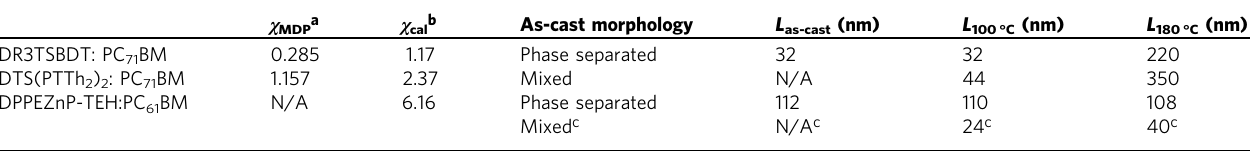
Table 1 Materials interaction parameters ( χ ) obtained by different methods and phase separation length ( L ) at different processing